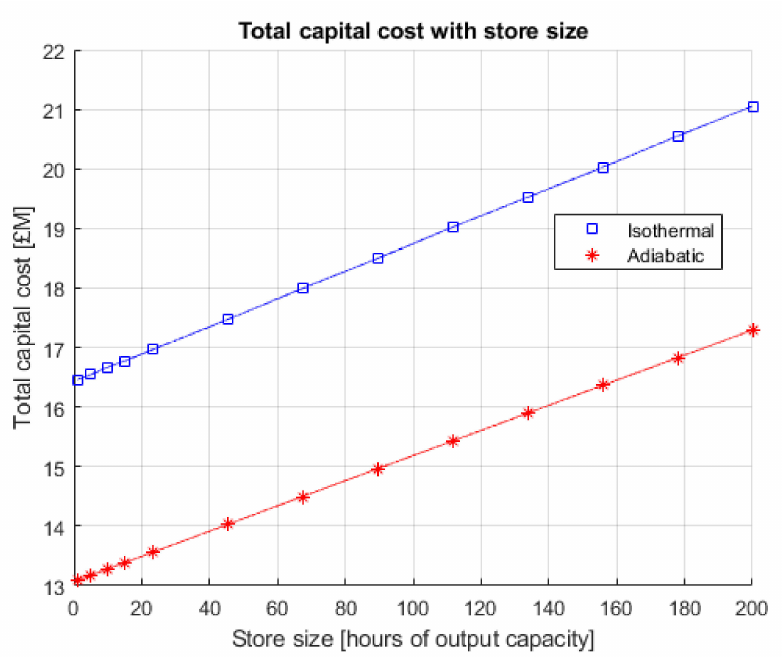
Figure 16. The relationship between total system cost and storage capacity for a representative system with the maximum allowable inlet swept